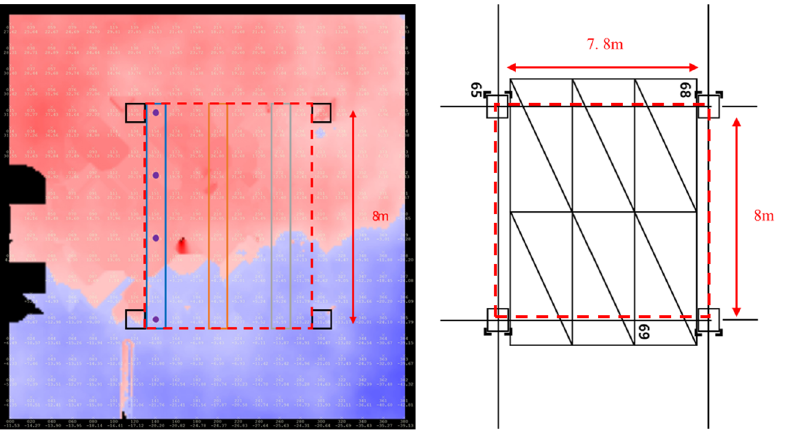
Figure 11. Relative deflection of slab floor from ‘Floor Inspection’ function of program (Post-processing step of target part).